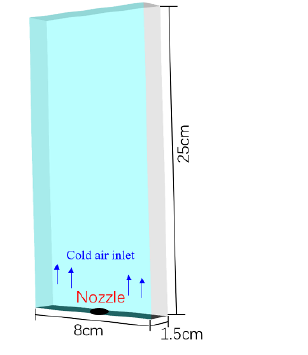
8 of 23 Table 2. Property of particles and wall in DEM. Parameter